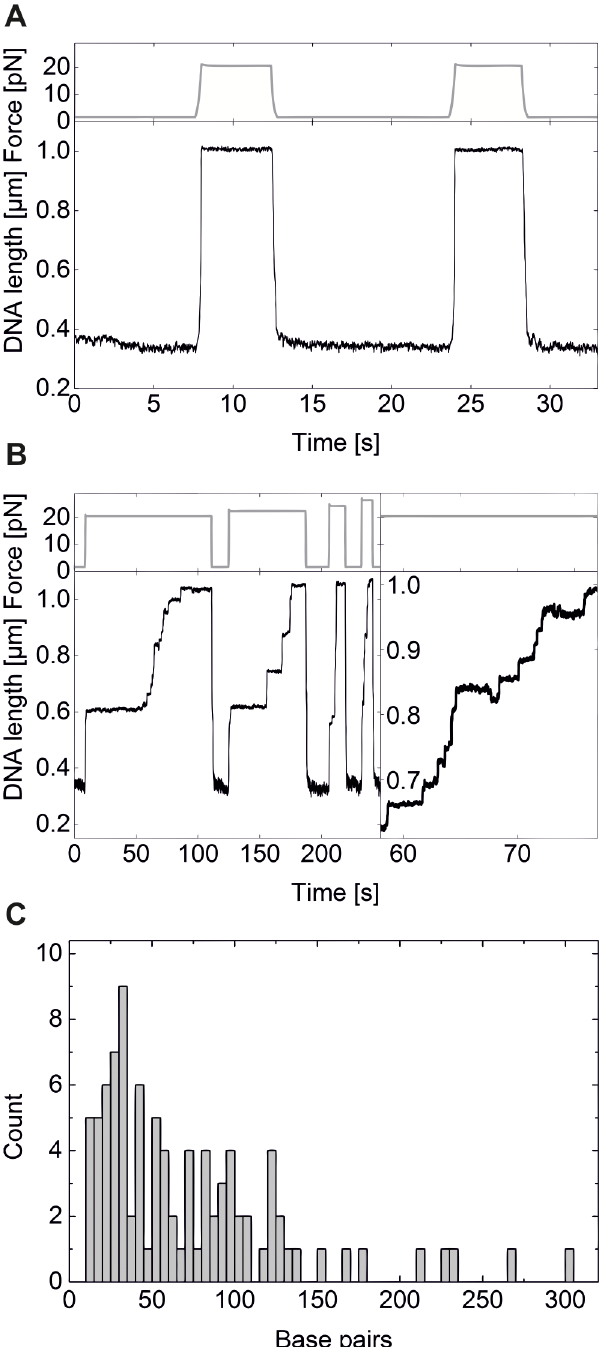
Fig 5. Hairpin unzipping at constant force reveals discrete protein dissociation events. (A) Time trajectory of DNA hairpin unzipping and rezipping in absence of TrmBL2. The force was alternated between 20.6 pN and 1.6 pN to induce the conformational changes of the hairpin. Hairpin unzipping occurred under these conditions in a single fast step. (B) Time trajectory of DNA hairpin unzipping and rezipping in presence of 30 μ M TrmBL2. Different forces from 20.6 pN to 26.5 pN were used for unzipping (see force axis). Hairpin opening occurred in small steps obviously due to displacement of bound protein (see detail in the right panel). (C) Number of base pairs unzipped in single steps for the traces shown under (B). The heights of the steps were determined manually and converted into the number of opened base pairs with a force-dependent algorithm